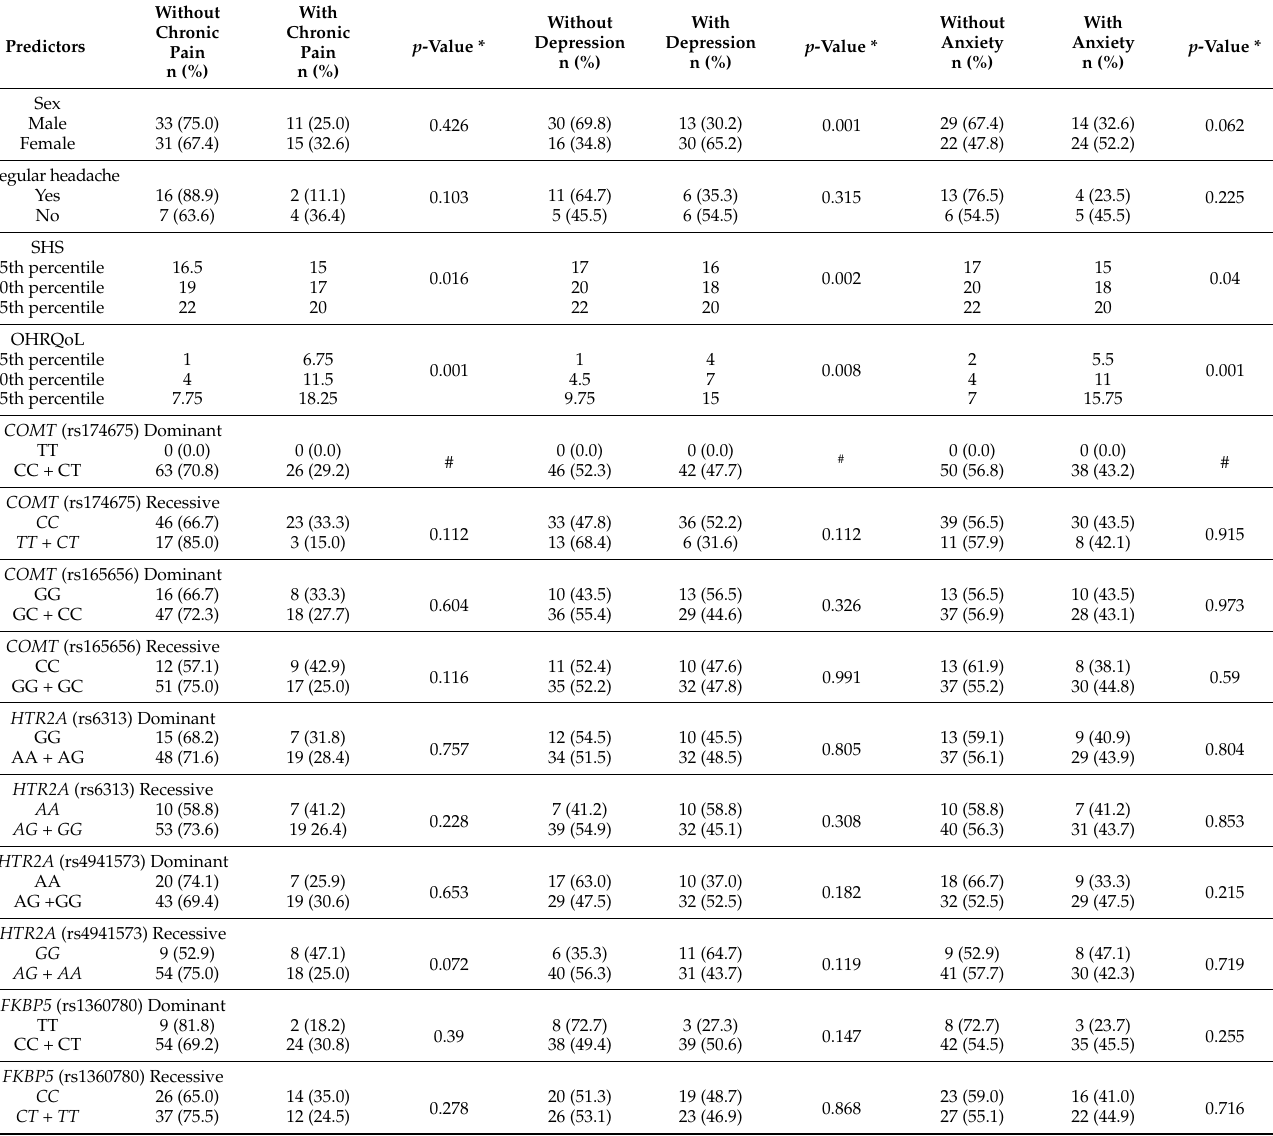
Table 3. Univariate logistic regression models for variables associated with chronic pain, depression and anxiety in